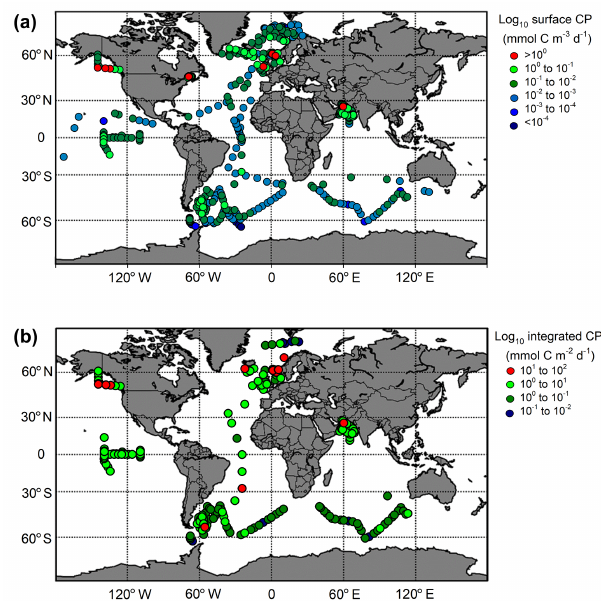
Figure 5. Global maps of (a) log-normalised surface CaCO 3 pro- duction (CP) and (b) euphotic zone log-normalised integrated CP. Global maps superimposed on ocean bathymetry as in Fig. 1a. Note that global maps represent all measurements and are not temporally resolved.